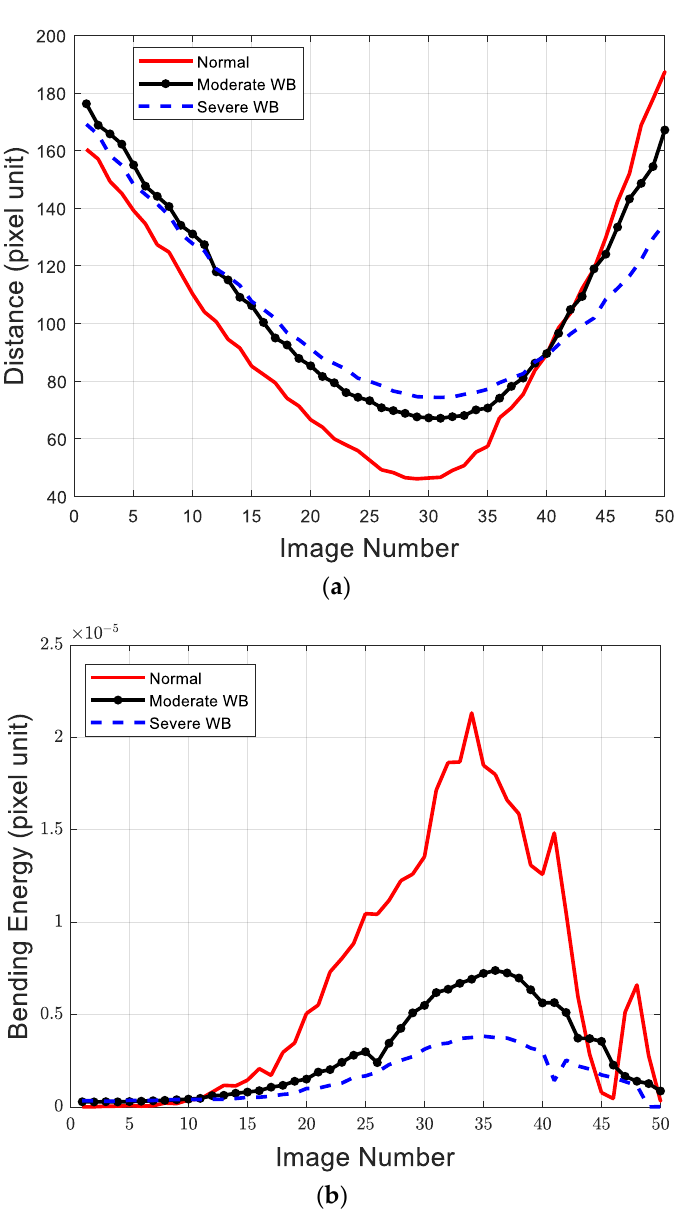
Figure 10. Raw data of measured ( a ) distance and ( b ) bending energy features in example normal, moderate WBC, and severe WBC fillets. Table 3. Performance scores of classification models: Results of 10 repeated five-fold cross-validations for each classification evaluation metric (OACC, BACC, F1, MCC) and at a line speed (10, 50, and 100 FPM only for MDM, NMDM, MBE, and AVGH) were averaged. The number in bold means the highest